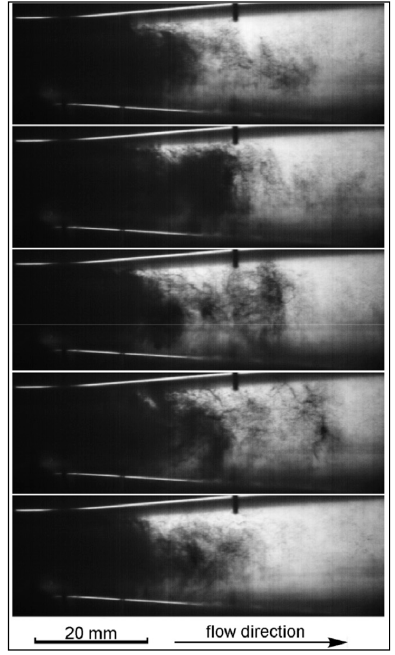
Figure 6. Condensation wave structure [62].